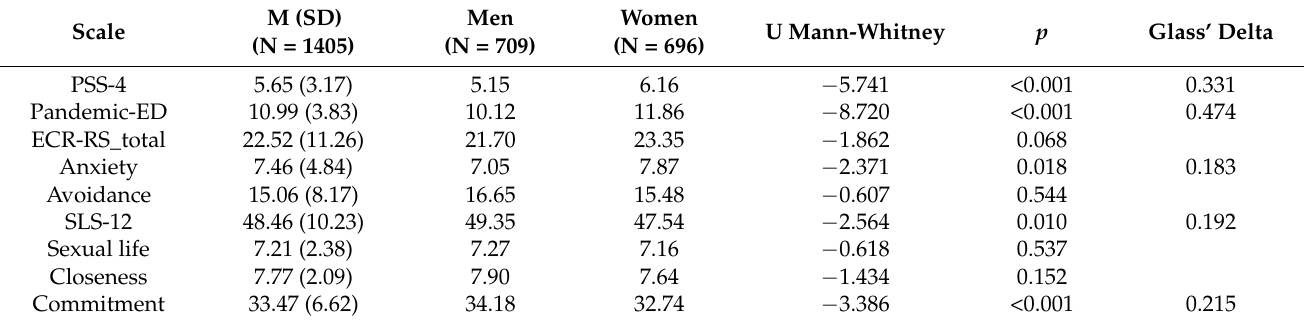
Table 5. Differences between women and men within the scope of the study scales (N =